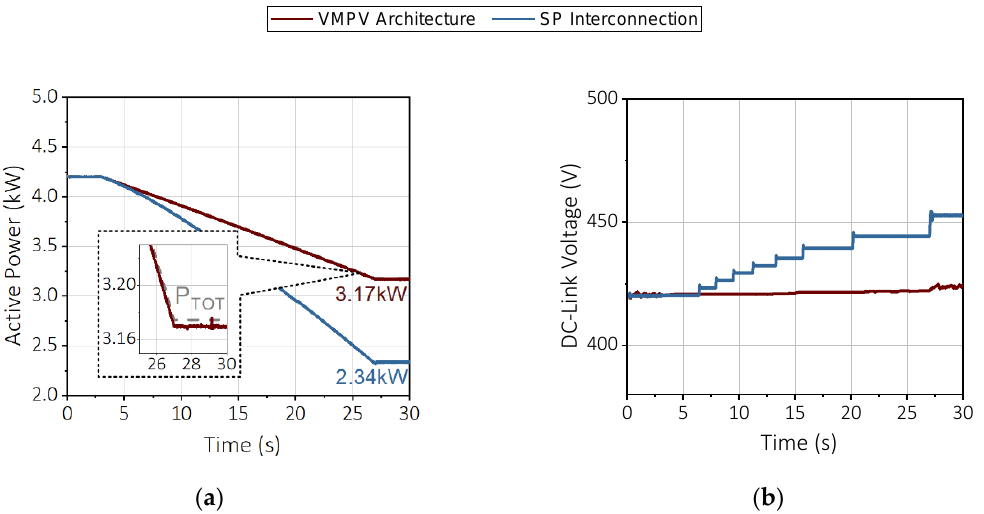
Figure 7. ( a ) Active power fed to the grid and ( b ) DC-bus voltage variation with time for the proposed VMPV under shading pattern A.